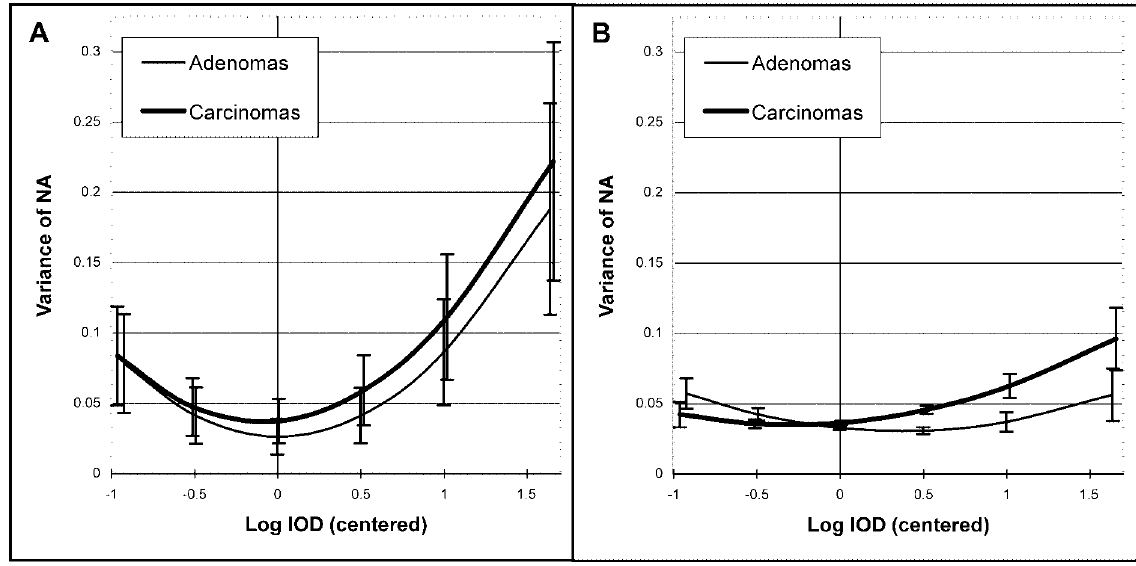
Fig. 2. Dependence of the variance of NA on IOD estimated separately for adenomas and carcinomas. A – between-tumor variance, B – within-tumor variance. Error bars represent 95% confidence